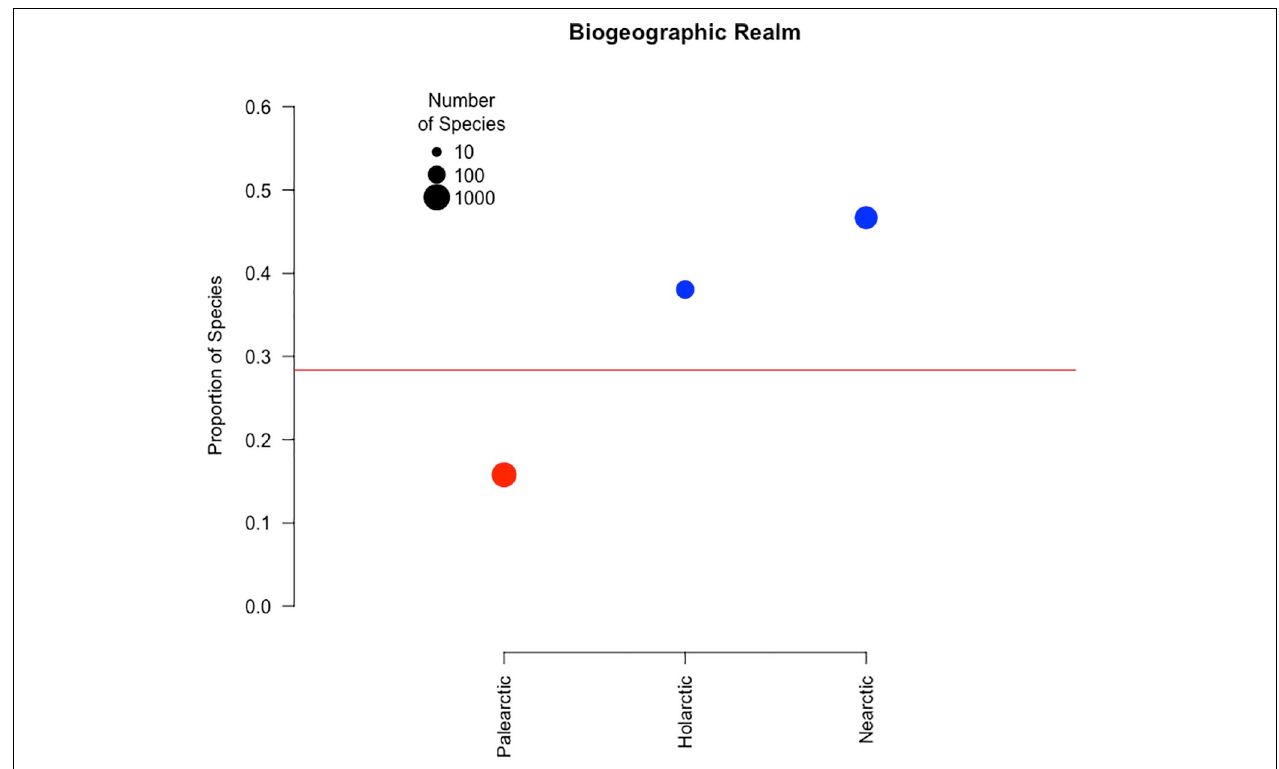
FIGURE 1 | The proportion of species that utilize temporary primary croplands by biogeographic realm. Point size indicates the total number of species within a category. Color represents the proportion of species within each group associated with cropland compared to the average association for migratory birds overall shown as a red line (28.3%): blue indicates a significantly higher than average proportion, red indicates a significantly lower than average proportion, and black indicates non-significant results.